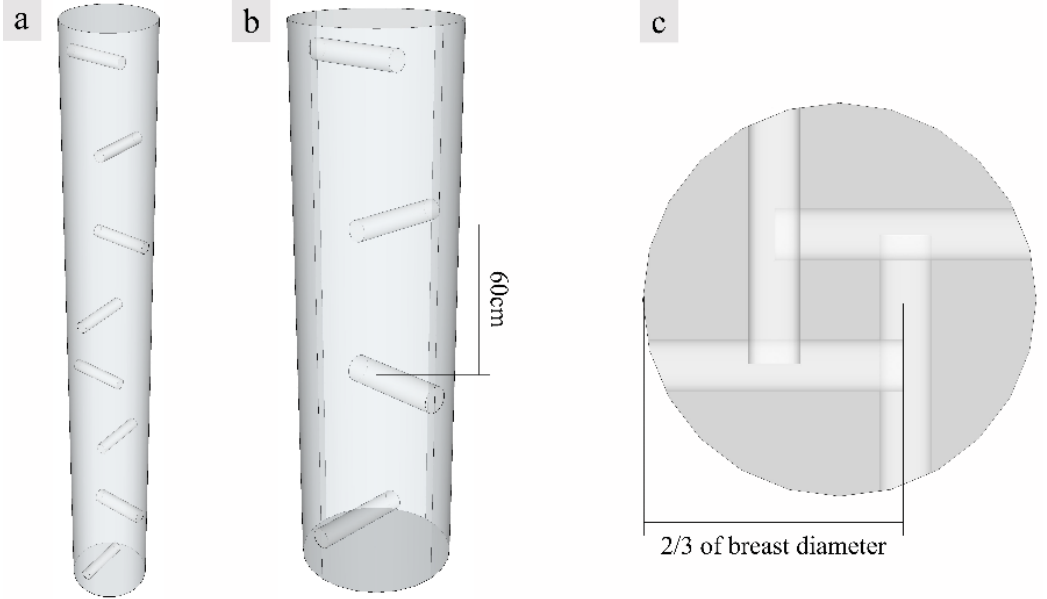
Figure 2. Diagram of fungal inducer inoculation sites; ( a ) Location of injection holes for the whole tree; ( b ) Enlargement of the diagram with the spacing of the inoculation holes; ( c ) Schematic of transverse surface. The height of the tree on the schematic was shortened in a ratio of 1:4 in order to allow for a complete presentation of the location of the inducer injection holes. allow for a complete presentation of the location of the inducer injection